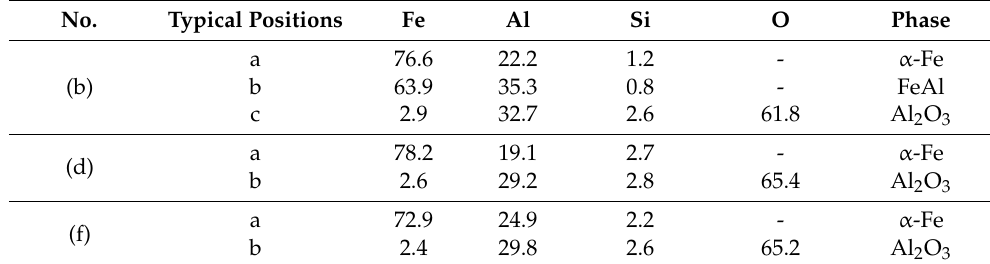
Table 5. Phase Analysis by EDS in Figure 6